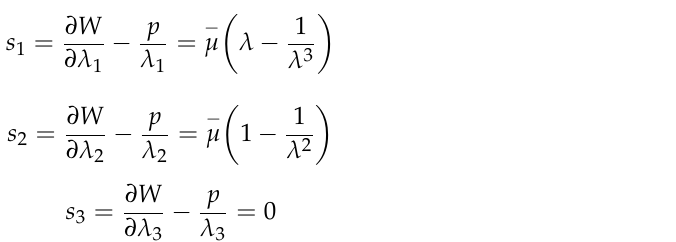
Figure 2. Different view of the soft actuator and its distal tip in bending state. ( a ) Side view. ( b ) Cross-sectional view. The nominal main strain s i can be defined by W , λ i . Where p , the Lagrange multiplier